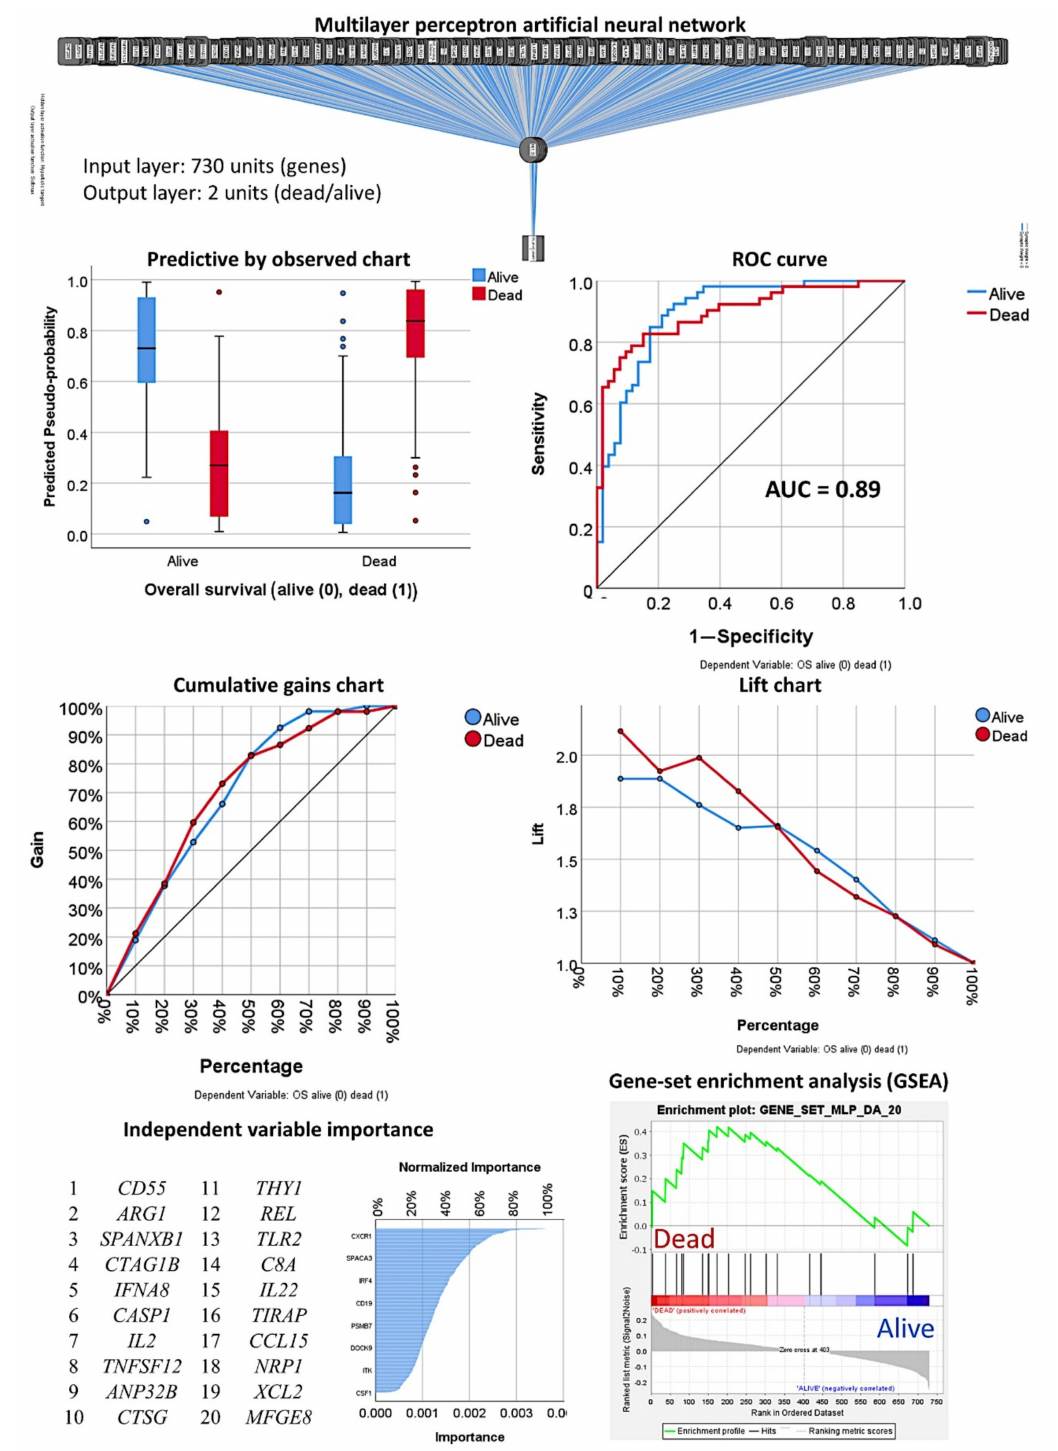
Figure 7. Multilayer perceptron artificial neural network for predicting overall survival. The neural network predicted the overall survival outcome as dead/alive using the 730 genes of the pancancer immune oncology profiling panel. The network performance can be checked using several parameters such as the area under the curve (AUC), which had a value of 0.89. The network performance outputs are the predictive by observed chart, the cumulative gains chart, and the lift chard. The genes were ranked according to their normalized importance for prediction of the overall survival outcome, as shown in the independent variable importance chart. The top 20 genes are listed. GSEA showed enrichment toward the dead phenotype for some